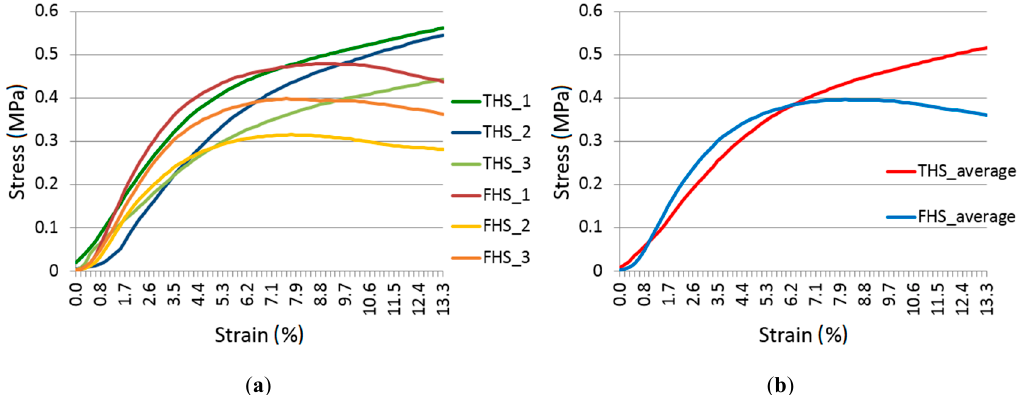
Figure 6. Stress–strain relationship: all samples ( a ) and average values ( b ).